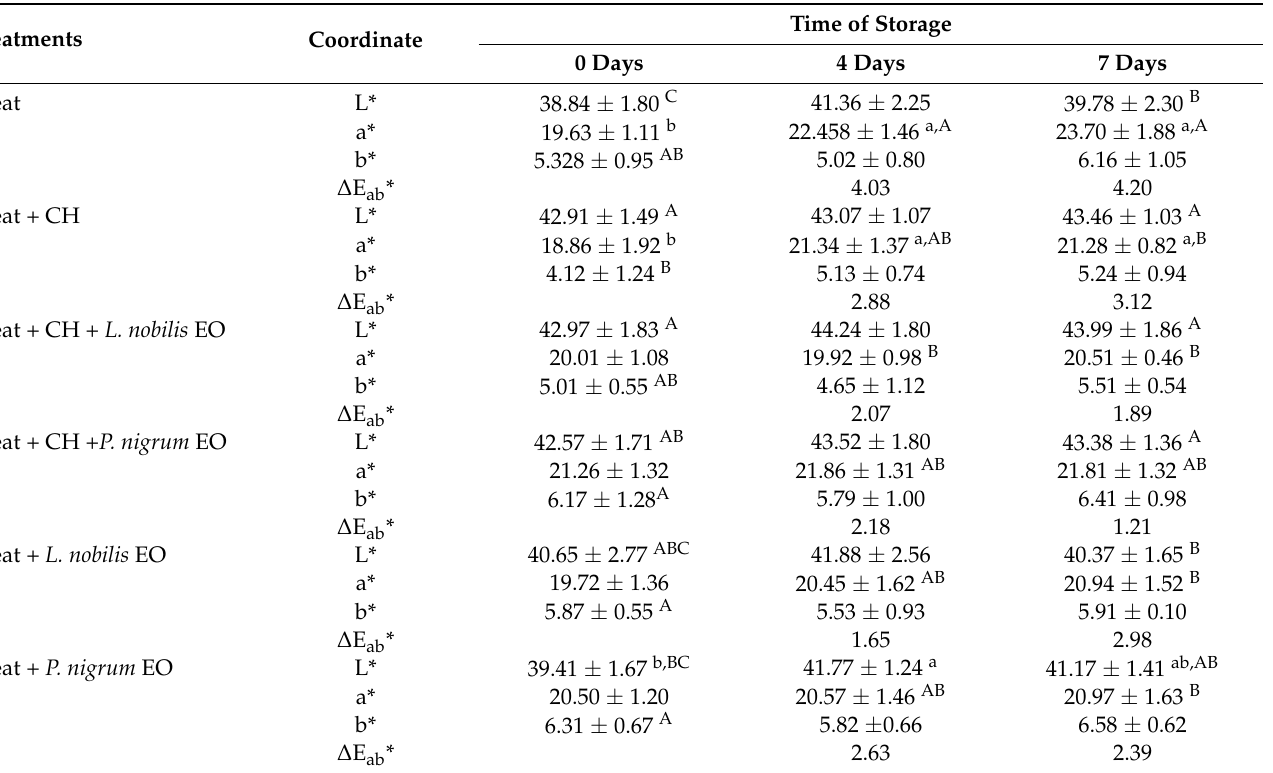
Table 4. L*, a*, and b* parameters (CIELAB) of beef patties subjected to different treatments for 7 days of cold